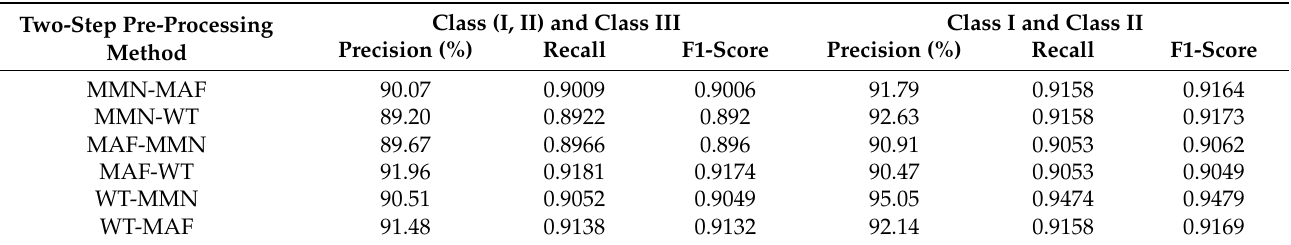
Figure 3. Reflectance of Max-Min Normalization and Moving-Average Filtering after the two-step pre-processing. Table 3. Precision, Recall, and F1-score for prediction of spectral data with 1D-CNN based on different two-step pre-processing methods.